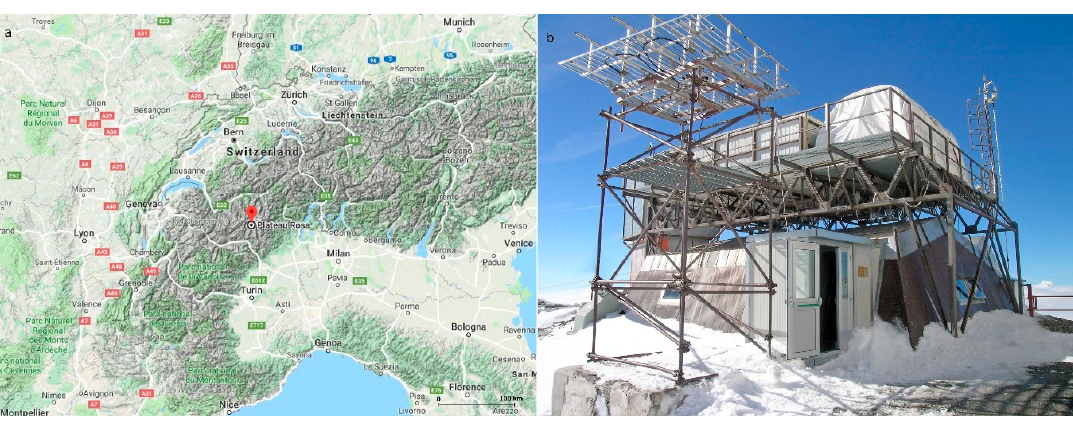
Figure 1. Geographical position of PRS (north-western Italian Alps, geographical coordinates: 45.93436° N, 7.70778° E, 3480 m a.s.l.) ( a ), picture of the PRS ( b ).